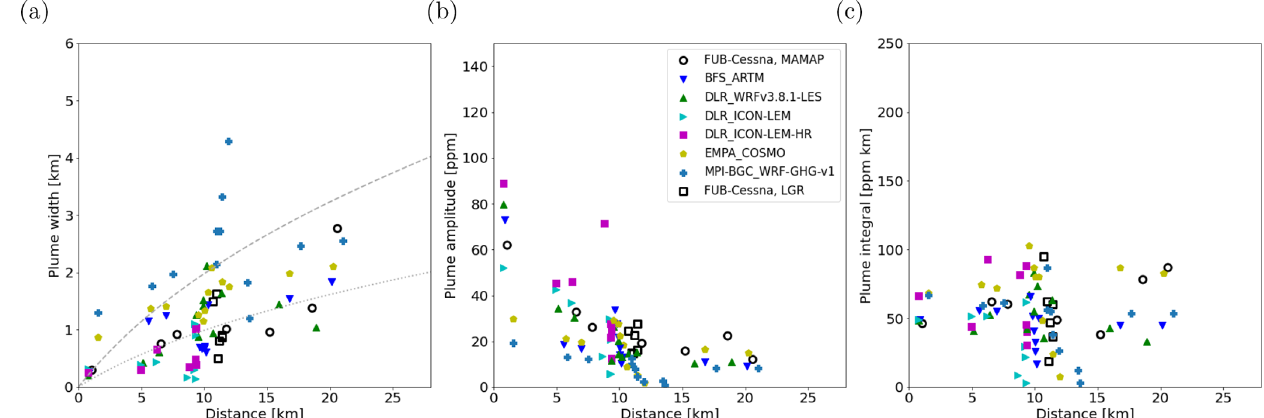
Figure 13. Same as Fig. 12 but for the FUB Cessna measurements collected at the Jänschwalde power plant on 23 May